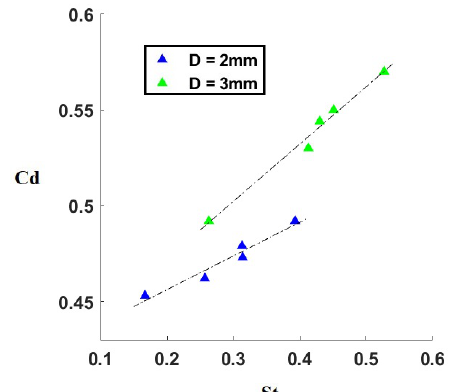
Figure 16. Strouhal numbers of the simulated water drops with respect to their drag coefficients (exact values and the corresponding cases are shown in Table